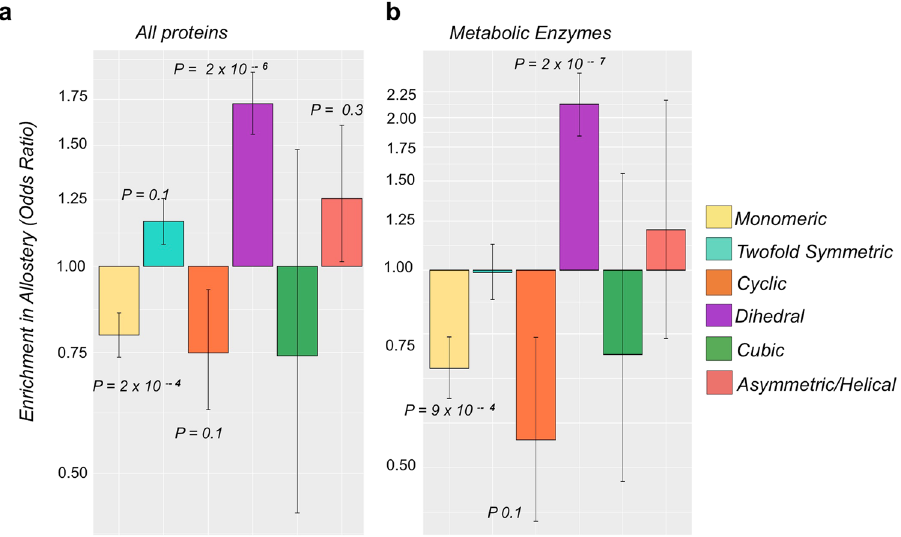
Figure 2. Enrichment of allostery in homomers from different symmetry groups. ( a ) Enrichment by complexes with closed symmetry in the subset of allosteric proteins. ( b ) A similar enrichment profile is seen when controlling for metabolic enzymes. The enrichment is calculated as the difference between the fraction of complexes in the specific set compared to the whole set of homomers. The enrichment is presented as the odds ratio, plotted on a logarithmic axis. P -values are calculated with Fisher’s exact test and error bars represent 68% melded binomial confidence